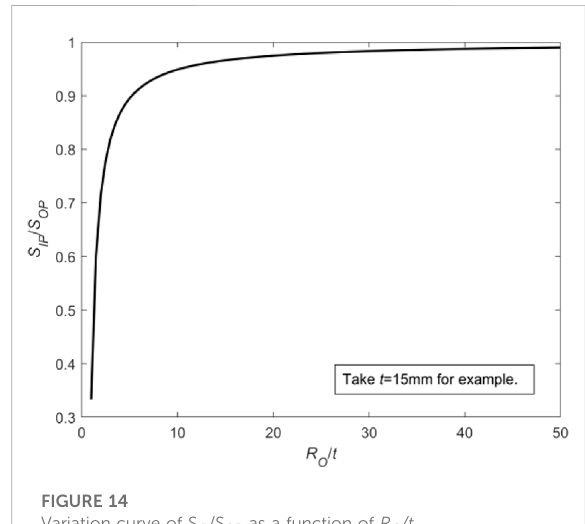
FIGURE 14 Variation curve of S IP /S OP as a function of R O /t .